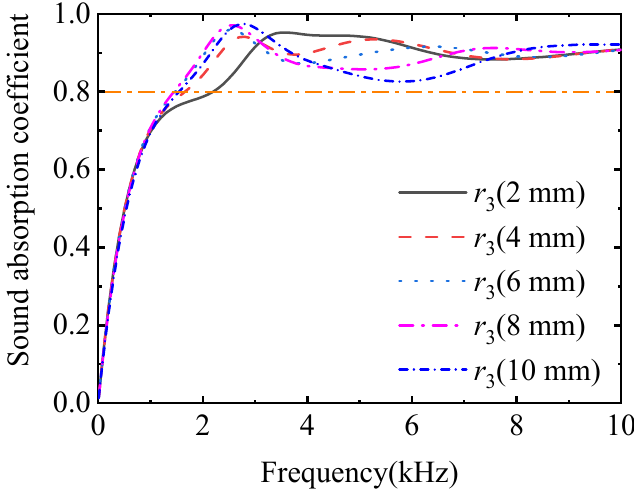
Figure 13. Comparison of α of NSSC corresponding to different cylinder radii.